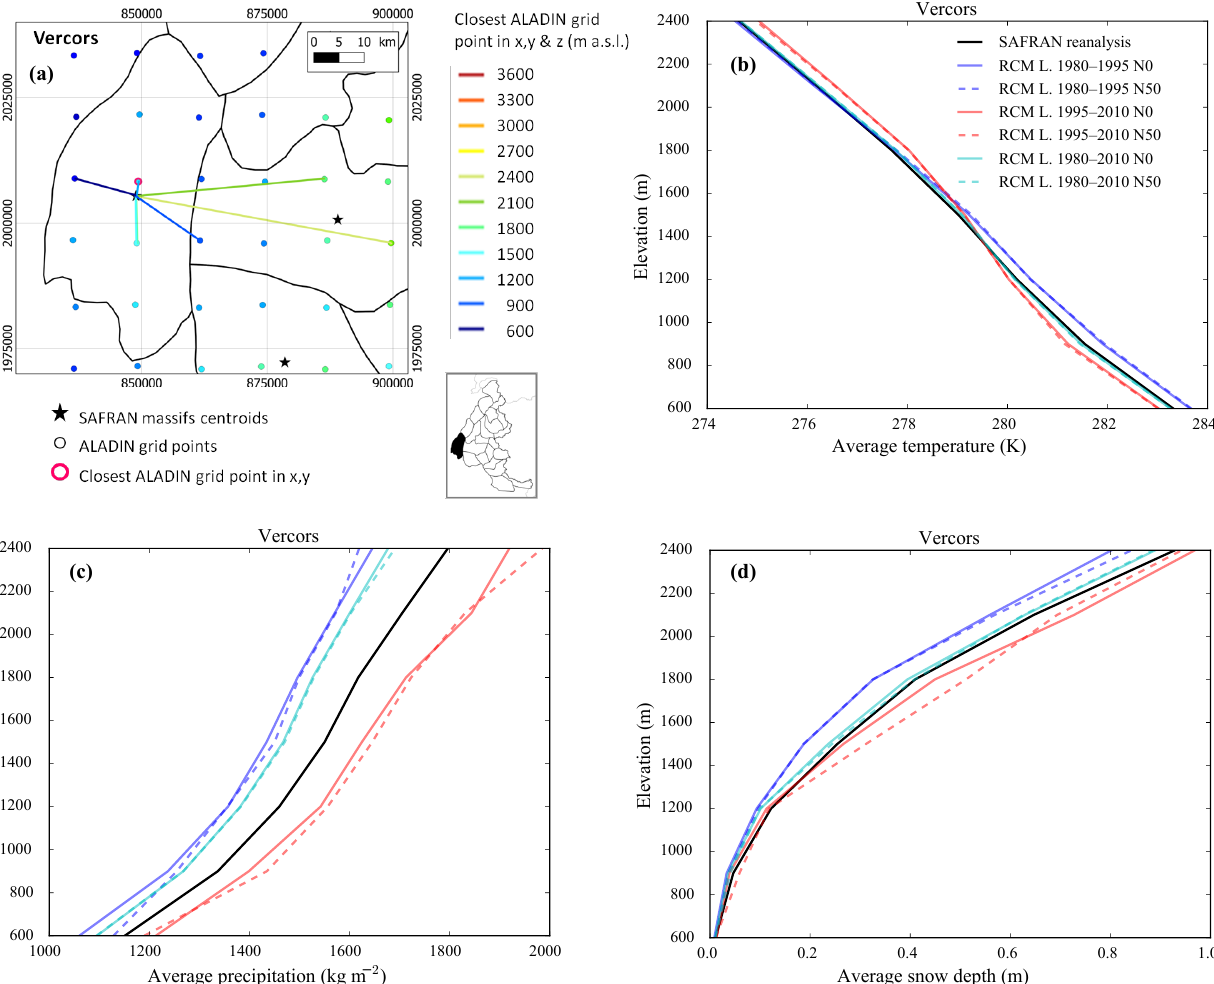
Figure 4. (a) Location of the Vercors massif with ALADIN RCM grid points chosen as the closest in x , y ( N = 0, pink circle) and in x , y and z (using N (cid:54)= 0). Coloured lines link each SAFRAN massif centre point with the corresponding grid point in ALADIN for the different elevations considered (600–2400ma . s . l . ). In this case the 1500 and 1800m lines are similar. (b) Mean temperature for each elevation band over the evaluation period in each adjusted RCM simulation (different learning periods and two grid point neighbour selection methods) and in SAFRAN (1980–2010). (c) Mean precipitation for each elevation band over the evaluation period. (d) Mean snow depth (using Crocus in this case) for each elevation band over the evaluation